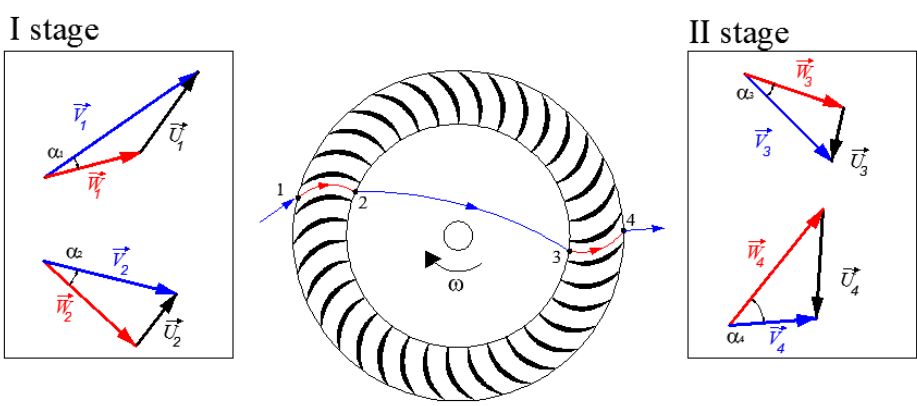
Figure 2. Points in the Euler’s